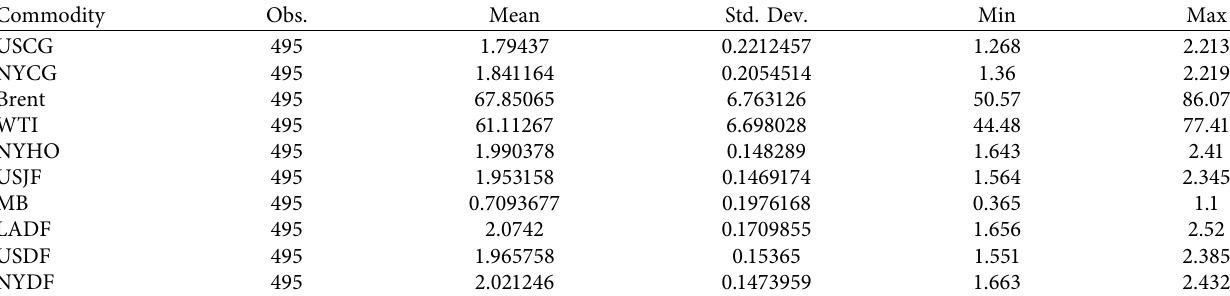
Table 3: Descriptive statistics of commodity prices.